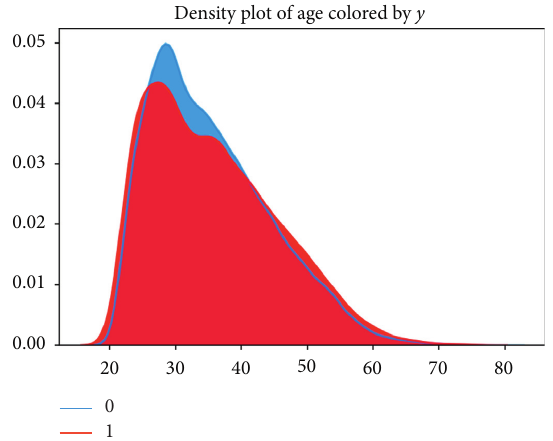
Figure 3: Density diagram of age.